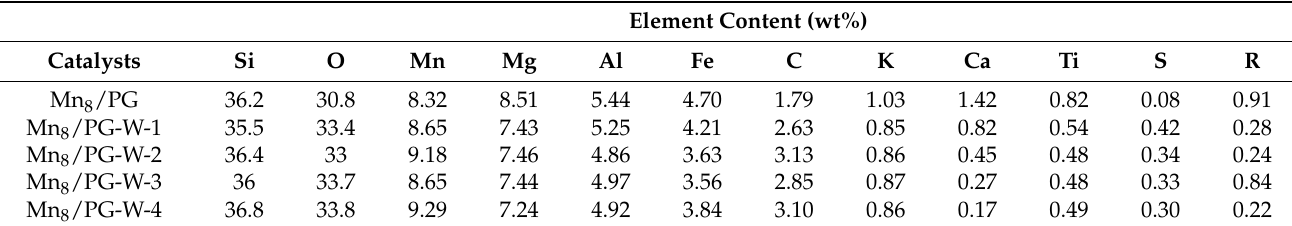
Table 2. Content of elements in different